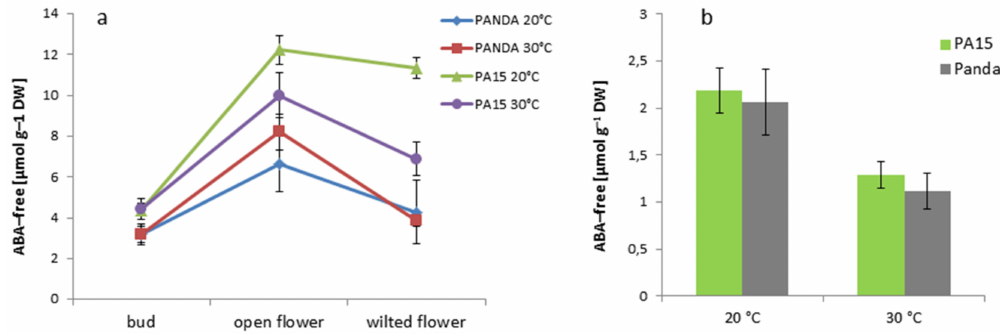
Figure 9. Content of ABA-free [ µ mol g − 1 DW] in the flower buds, open flowers, and wilted flowers ( a ) and the leaves ( b ) of the ‘Panda’ and PA15 plants grown at 20 ◦ C (control) and 30 ◦ C (thermal stress). Means ( n = 3) ±